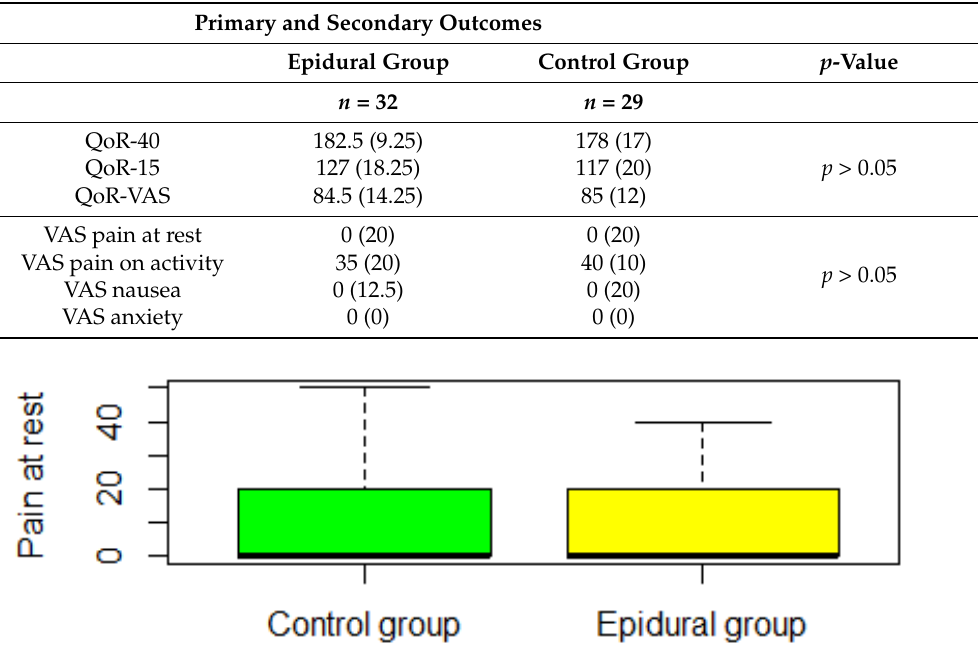
Table 2. Primary and secondary outcomes. Data are presented as median (IQR). Global multivariate inference test was used for obtaining p -value.